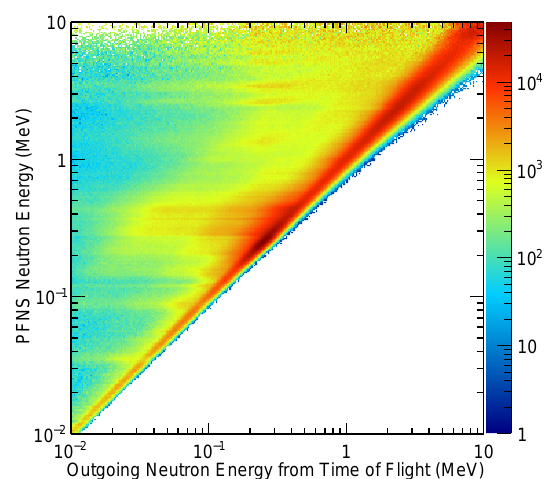
Figure 2: The neutron response matrix for the 239 Pu Chi- Nu PFNS experiment using the Li-glass detector array.